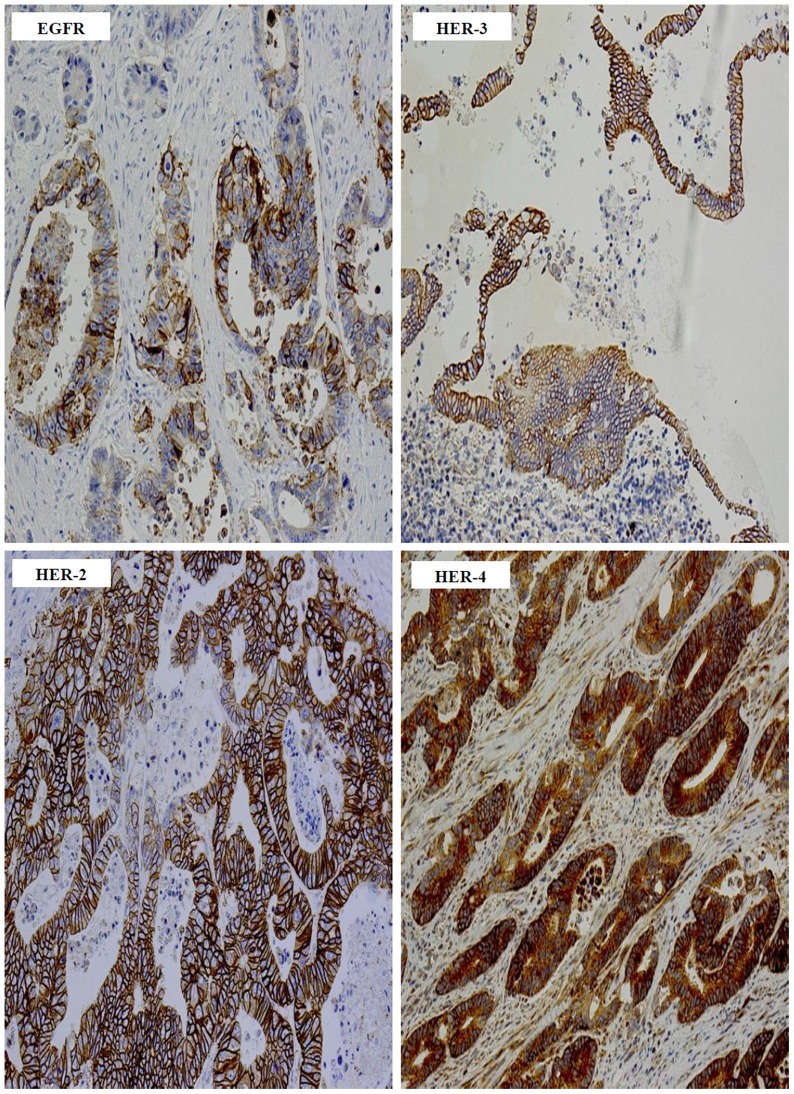
The immunostaining of HER family members in Dukes’ C and D colon cancer specimens.Immunostaining of EGFR 3+, HER-2 3+, HER-3 2+, and HER-4 3+ in formalin fixed paraffin embedded tumour sections stained immunohistochemically, as described under methods and patients section. Magnification: ×200.